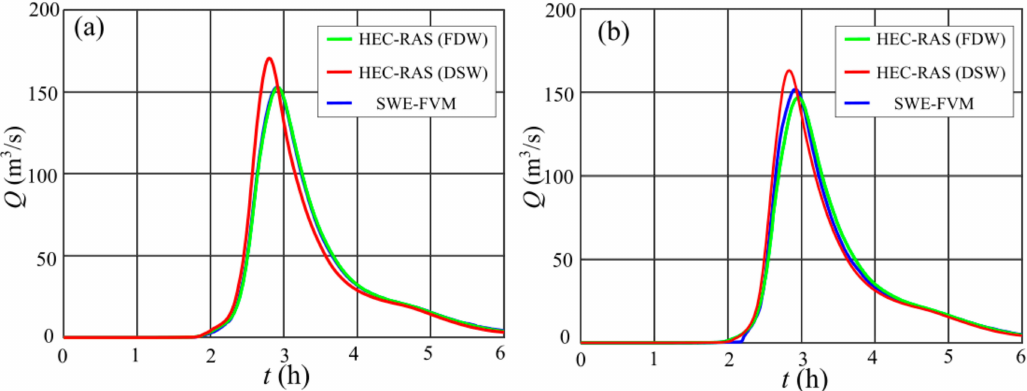
Figure 4. Discharge hydrograph simulated with HEC-RAS and SWE-FVM models for a return period of 30 years: element size 5 m ( a ) and 10 m ( b